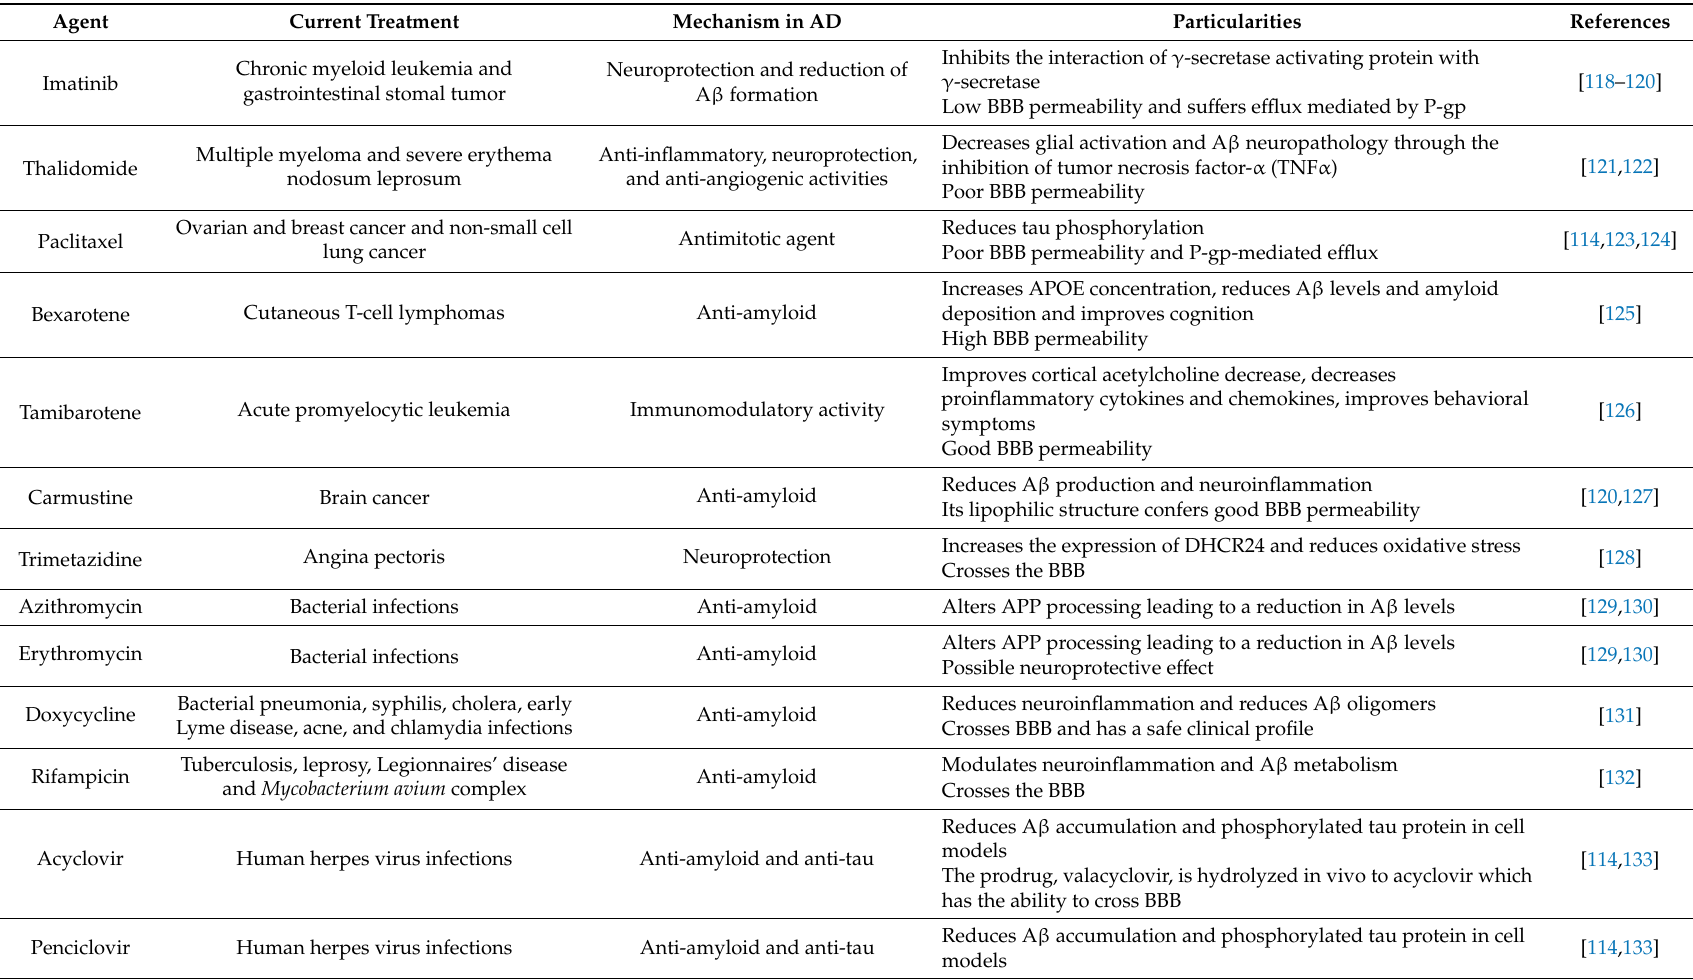
Table 3. Candidates for drug repurposing in AD